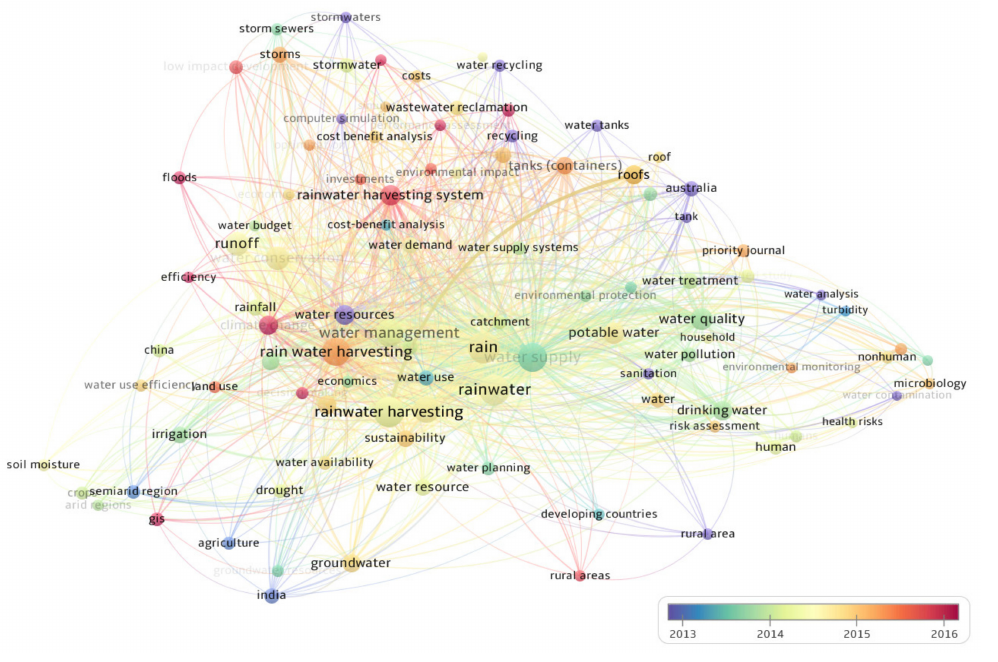
Figure 7. The occurrence network map of all keywords (keywords plus and author’s keywords) of RWH area.